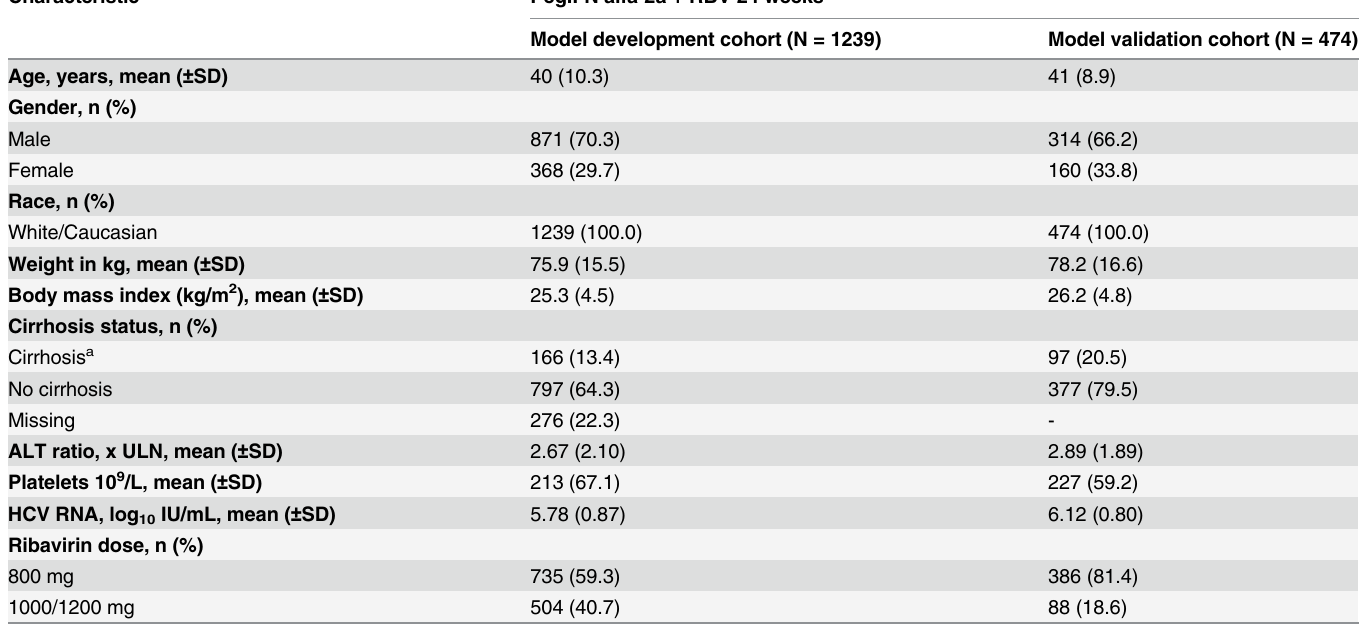
Table 1. Baseline demographic and disease